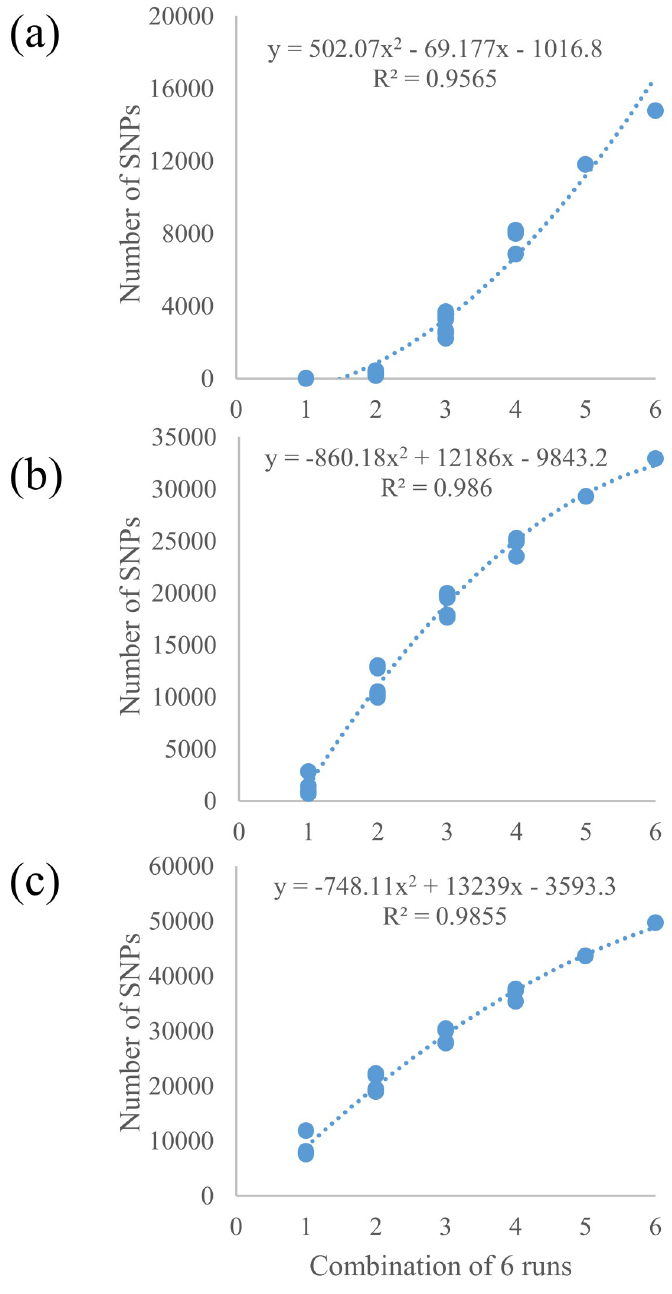
Fig 1. Relationship between numbers of sequencing runs and the numbers of SNPs with (a) < 20%, (b) < 50%, and (c) < 80% missing data for the first library of 288 Iranian wheat genotypes. (Table 3). The W7984 assembly and IWGSC RefSeq v1.0 had similar transition/transversion ratios to the CSSS assembly, but with slightly higher numbers of total SNPs (Tables 2 and 4). The numbers of SNPs per chromosome were significantly correlated to the chromosome sizes (Mbp) in all four references. Although they were all significant, the correlations were much lower for the barley reference genome (R 2 ~ 0.41 �� , Fig 2a) and wheat CSSS assembly